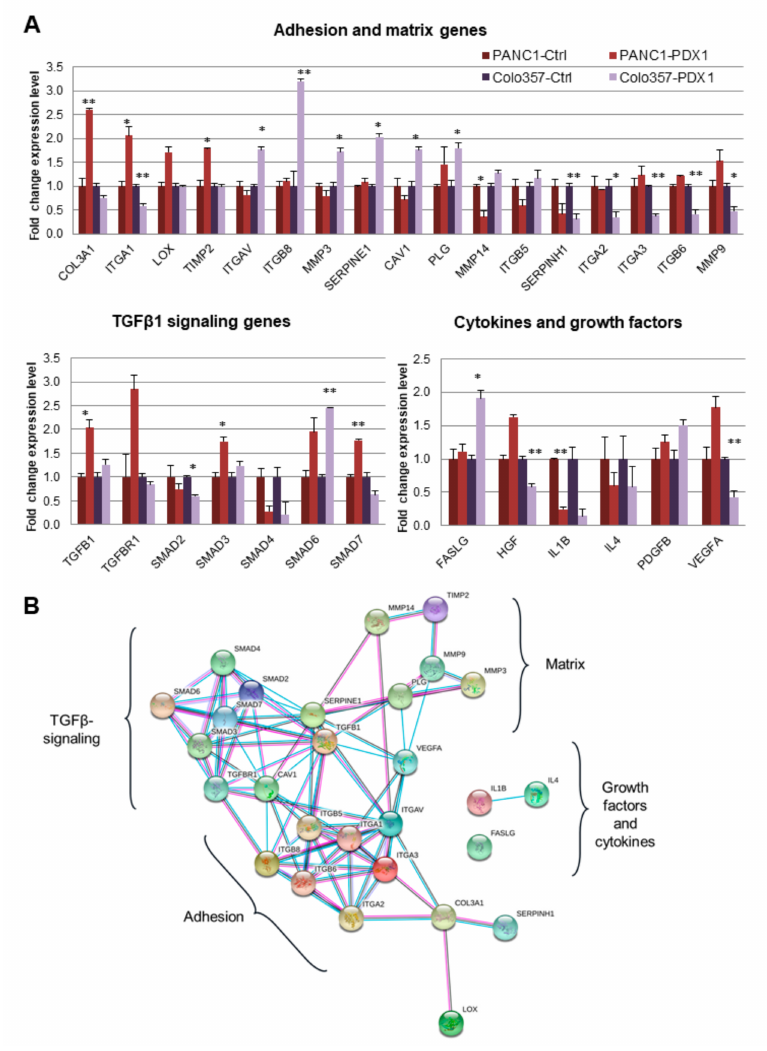
Figure 3. Influence of the PDX1 gene on the motility genes expression. ( A ) Motility genes expression. The data are shown as the mean ± SD ( n = 3). * p < 0.05, ** p < 0.01. ( B ) Functional protein association network of genes with changed expression based on STRING database (https://string- db.org/Version11.0b, Date: 17 October 2020 to 12 August